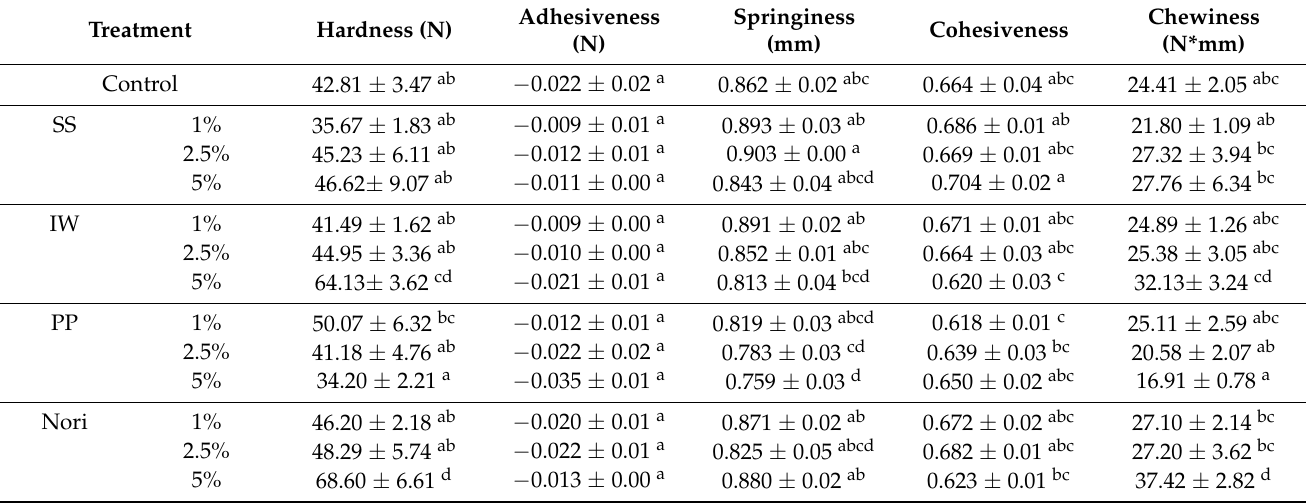
Table 4. TPA of control sausage and sausages containing 1%, 2.5%, and 5% brown and red sea- weed